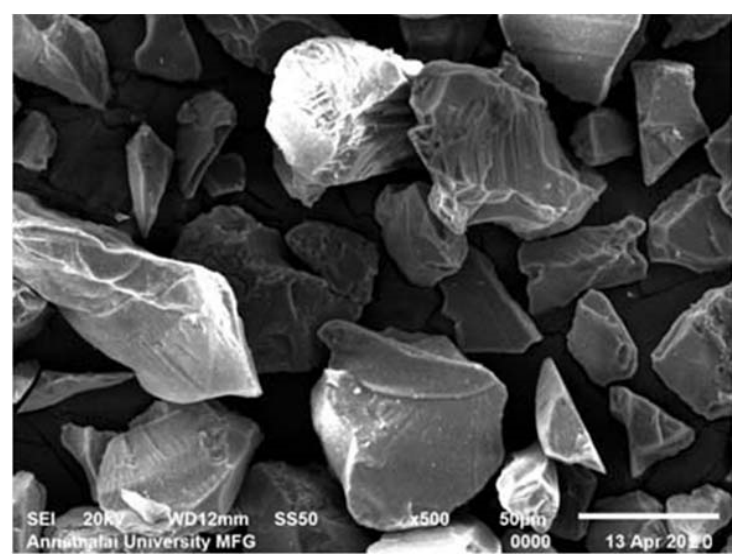
Figure 5. SEM micrograph of the erodent particles.